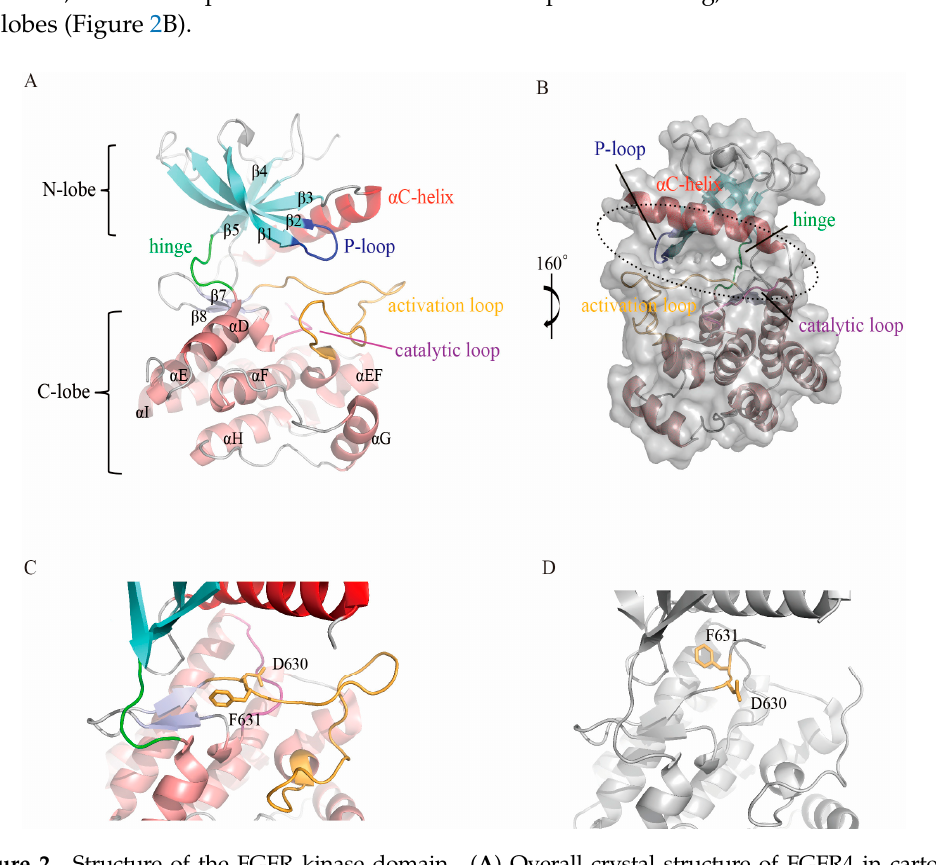
Figure 2. Structure of the FGFR kinase domain. ( A ) Overall crystal structure of FGFR4 in cartoon representation. The five β -sheets of the N-lobe are labeled in cyan, and the helixes of the C-lobe are colored in salmon. The α C helix (red), P-loop (blue), catalytic loop (magenta), activation loop (bright orange) and hinge (green) are highlighted. ( B ) Surface presentation of FGFR4. The ATP binding pocket located between the N- and C-lobe is indicated by the dashed circle. ( C ) DFG-out conformation of the FGFR4 activation loop. The side chains of D630 and F631 are shown in stick representation. ( D ) DFG-in status of the FGFR4 activation loop. ( A ), ( B ) and ( C ) were prepared from PDB ID 4UXQ; ( D ) was prepared from PDB ID 5JKG.